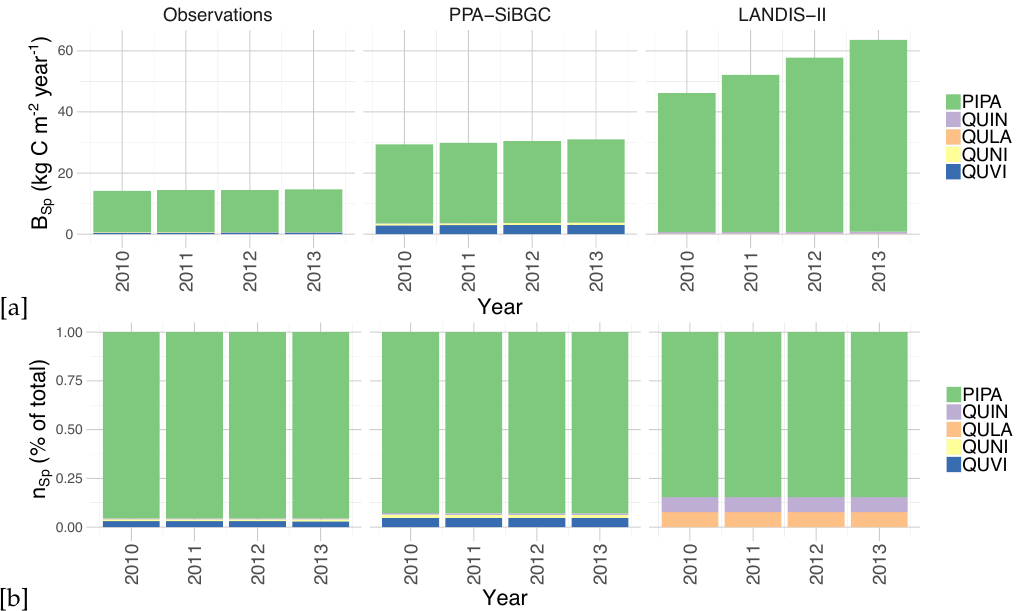
Figure 9. JERC-RD: Simulated and observed species aboveground biomass and relative abundance; ( a ) = biomass; ( b ) = abundance; left = observations, middle = PPA-SiBGC, right = LANDIS-II NECN; note that different scales are used for